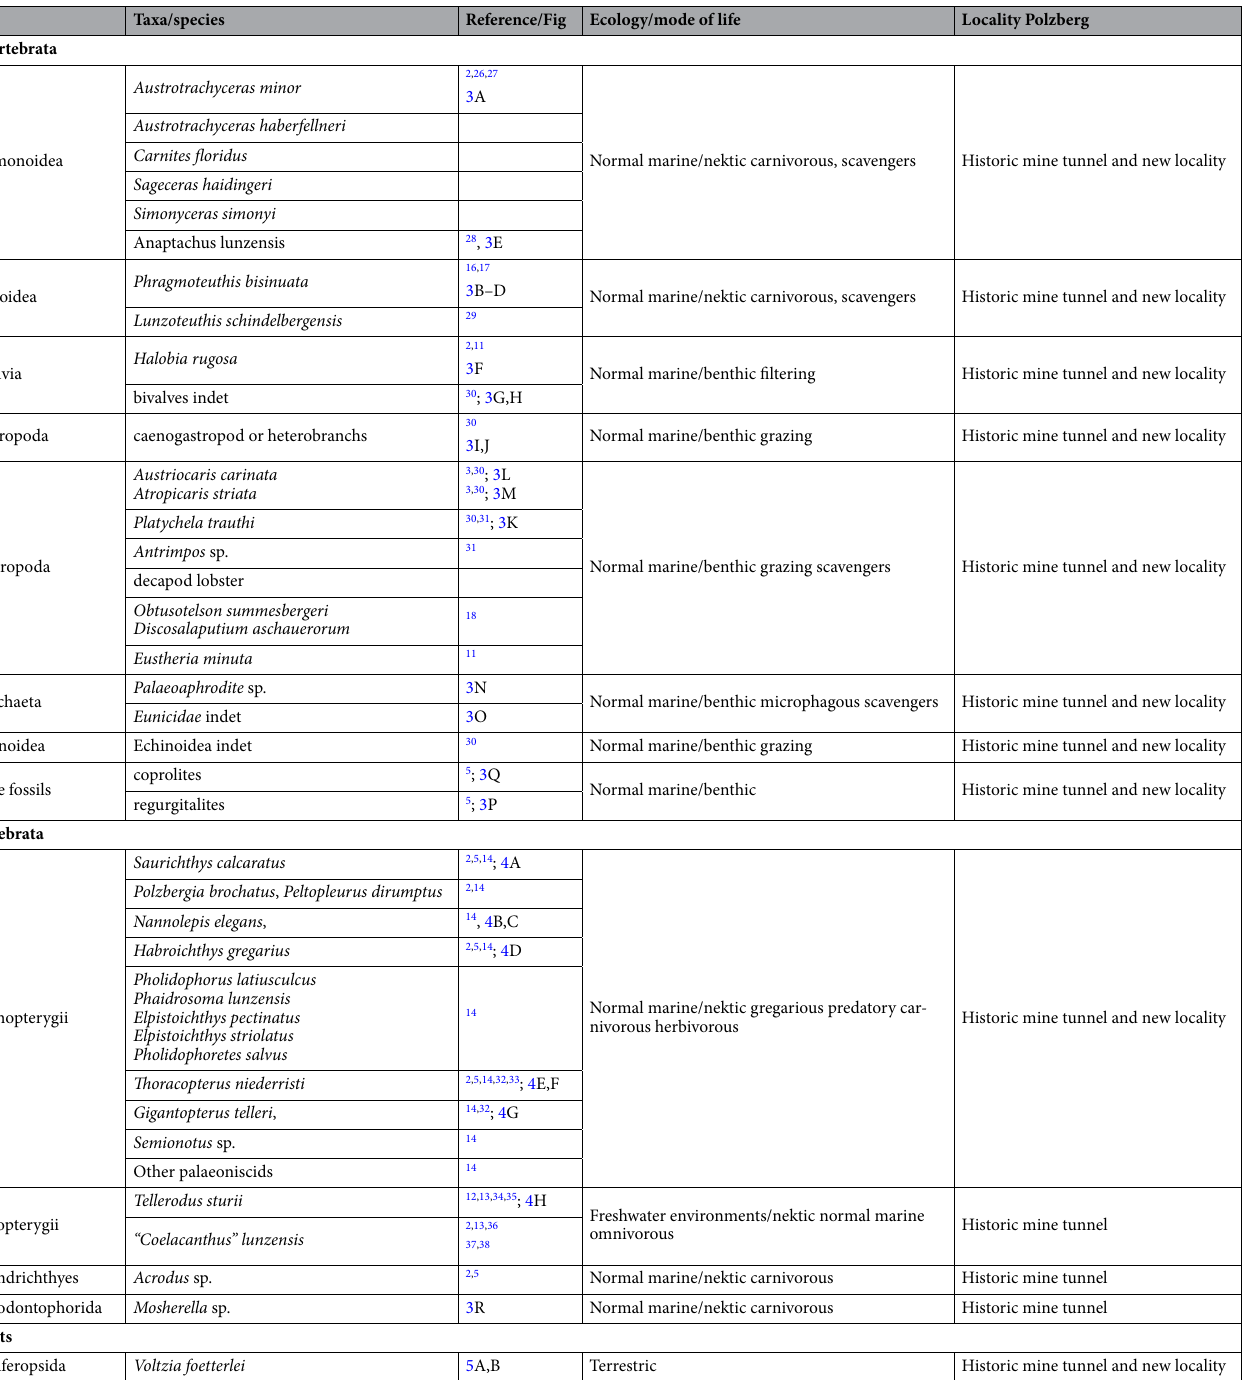
Table 1. Showing the taxa from the Carnian Polzberg palaeobiota. Indicated are the taxonomic groups, the genera/species; ref/fig consecutive numbers to references and figures in the main text and reference list. Ecology and mode of life are given with information to the detailed locality historic or recent